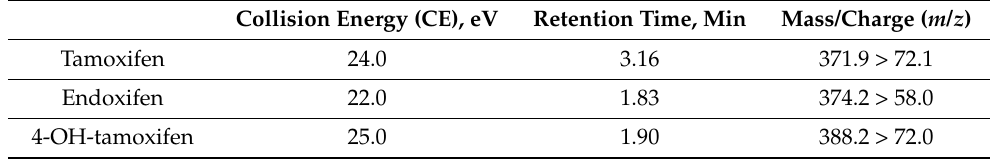
Table 3. HPLC/MS conditions for metabolite quantification in extracts. Collision Energy (CE), eV Retention Time,